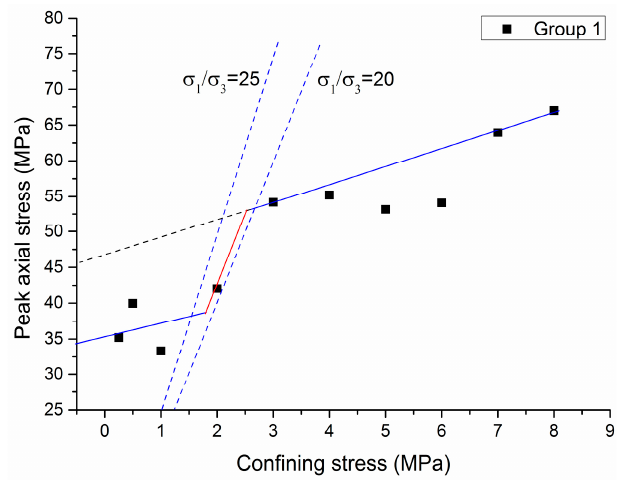
Figure 12. Strength evolution under a wide range of confinement.